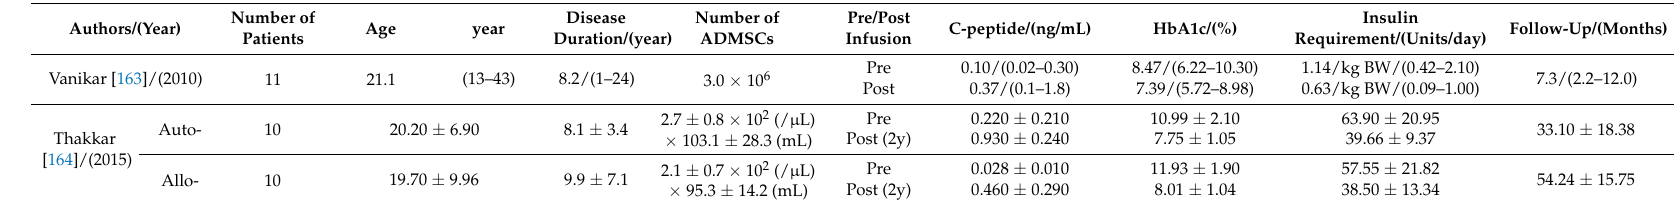
Table 3. Diabetes clinical trials using adipose tissue-derived stromal cells